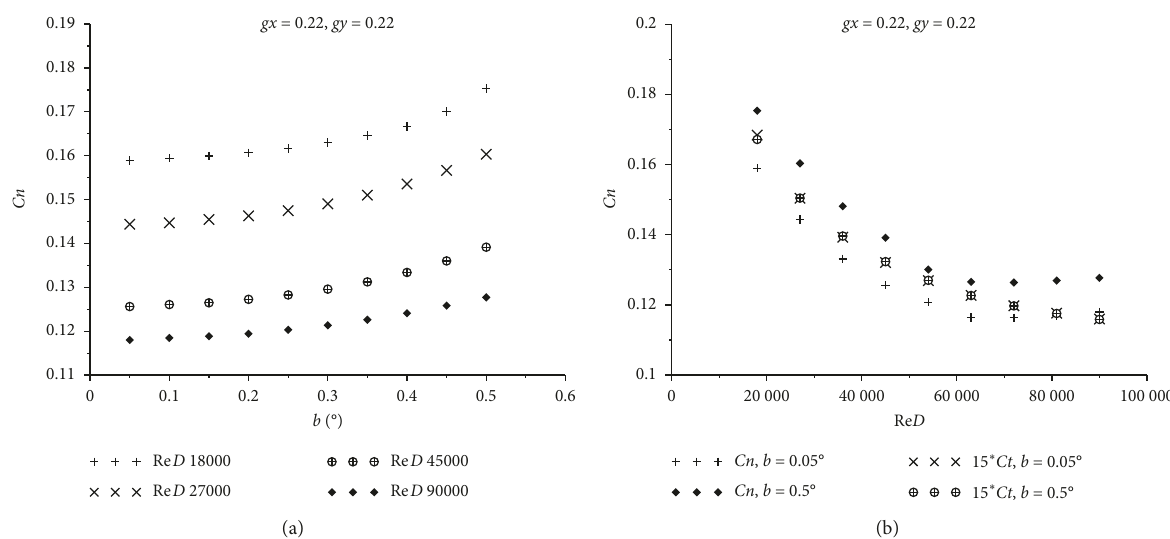
Figure 6: Evolution of Cn as a function of the angle b (a) and as a function of the Reynolds number Re D (b), for a small